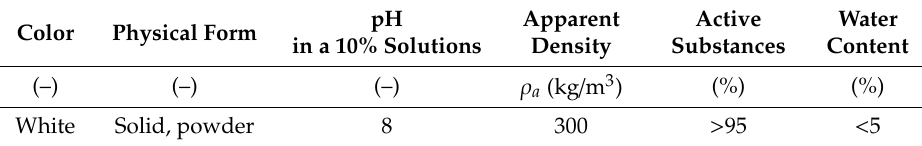
Table 3. Properties of the Plast Retard used in the research